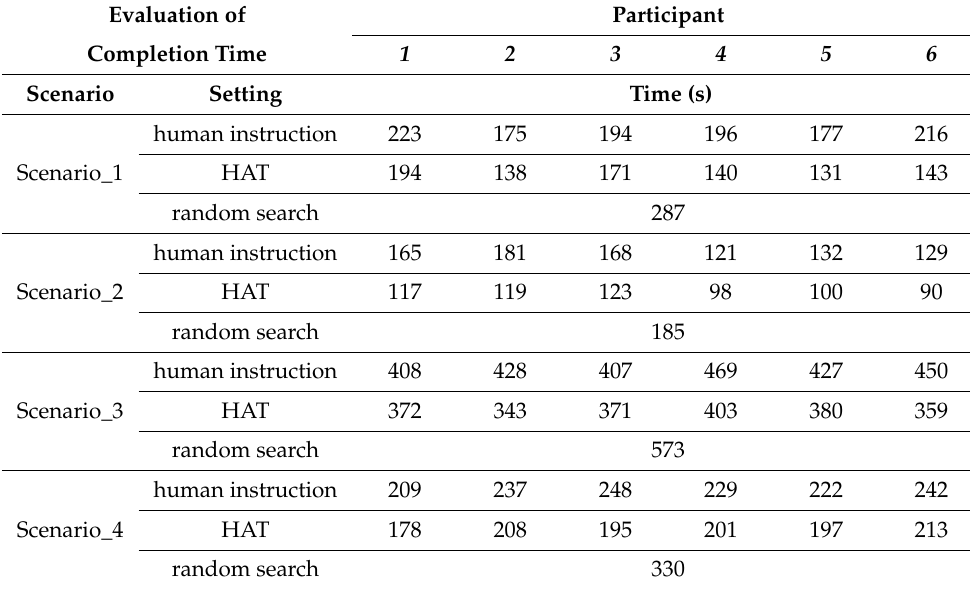
Table 2. Completion time under Scenario_1–4, HAT represents experiments with control switching between the human and